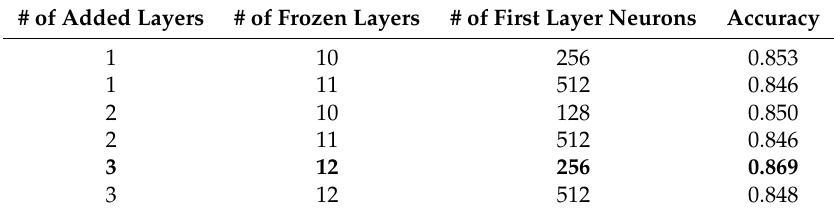
Table 2. Some tests on fine-tuning with VGG16 topology and relative accuracy values. The best choice of parameters in terms of validation accuracy is highlighted in boldface font.